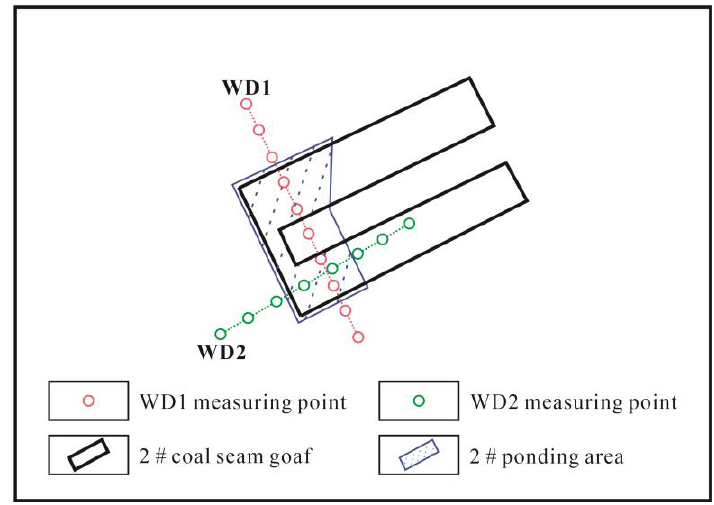
Figure 4. Layout of measuring points and goaf scope of Coal Seam #2.